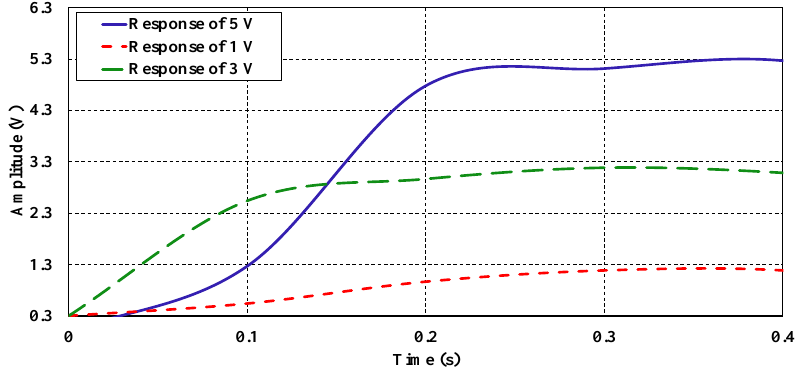
Figure 13. Sample step responses of the piezoelectric bimorph due to different step